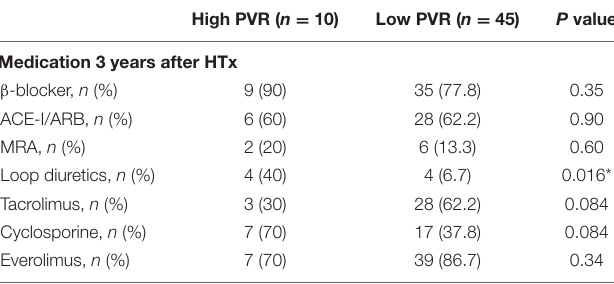
TABLE 4 | Oral medication 3 years after HTx in two